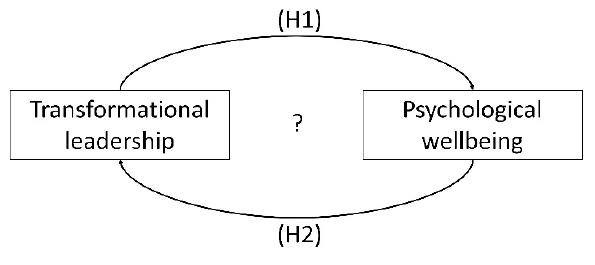
Figure 1. Conceptual model.